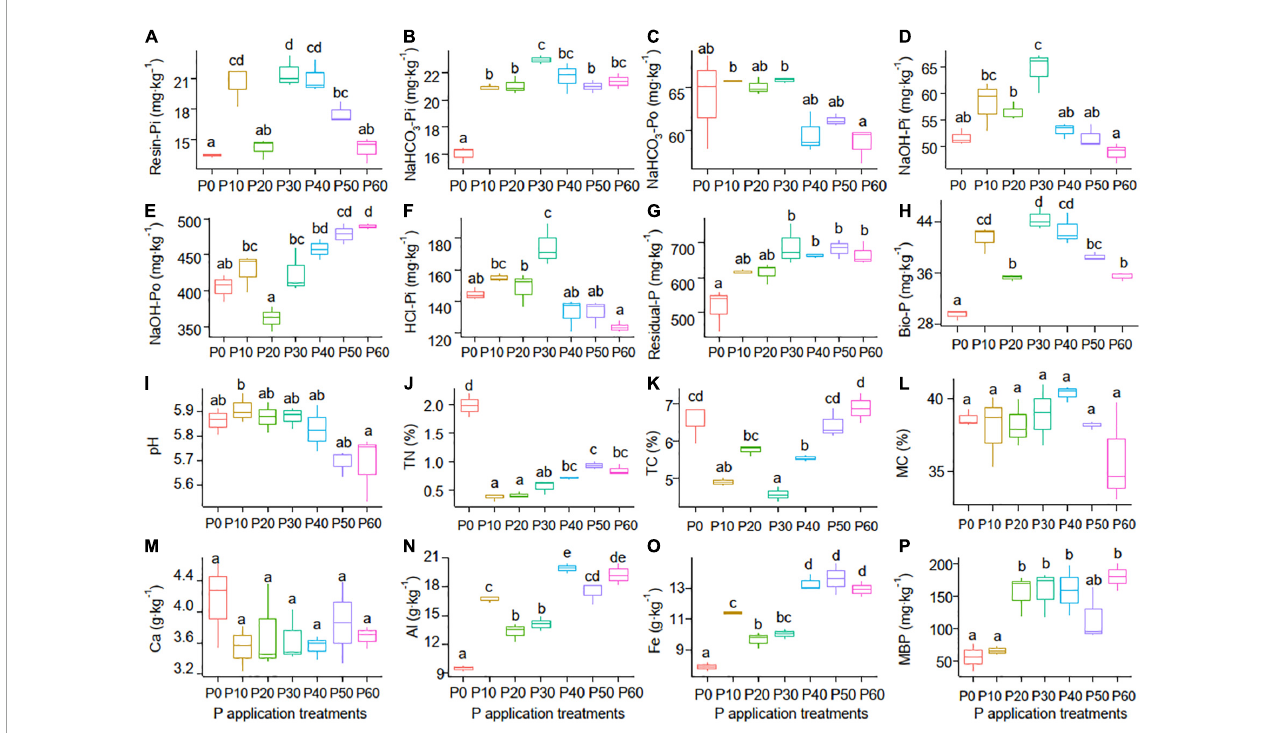
FIGURE1 Soil P forms [Resin-Pi (A) , NaHCO 3 -Pi (B) , NaHCO 3 -Po (C) , NaOH-Pi (D) , NaOH-Po (E) , HCl-Pi (F) , Residual-P (G) , and Bio-P (H) ] and physicochemical properties [pH (I) , TN (J) , TC (K) , MC (L) , Ca (M) , Al (N) , Fe (O) , and MBP (P) ] among the seven P application treatments. P0 (without phosphate fertilizer), P10 (with a rate of 10 g · m − 2 · a − 1 ), P20 (with a rate of 20 g · m − 2 · a − 1 ), P30 (with a rate of 30 g · m − 2 · a − 1 ), P40 (with a rate of 40 g · m − 2 · a − 1 ), P50 (with a rate of 50 g · m − 2 · a − 1 ), and P60 (with a rate of 60 g · m − 2 · a − 1 ). Bio-P, bioavailable P; TN, total nitrogen; TC, total carbon; MC, moisture content; MBP, microbial biomass phosphorus.